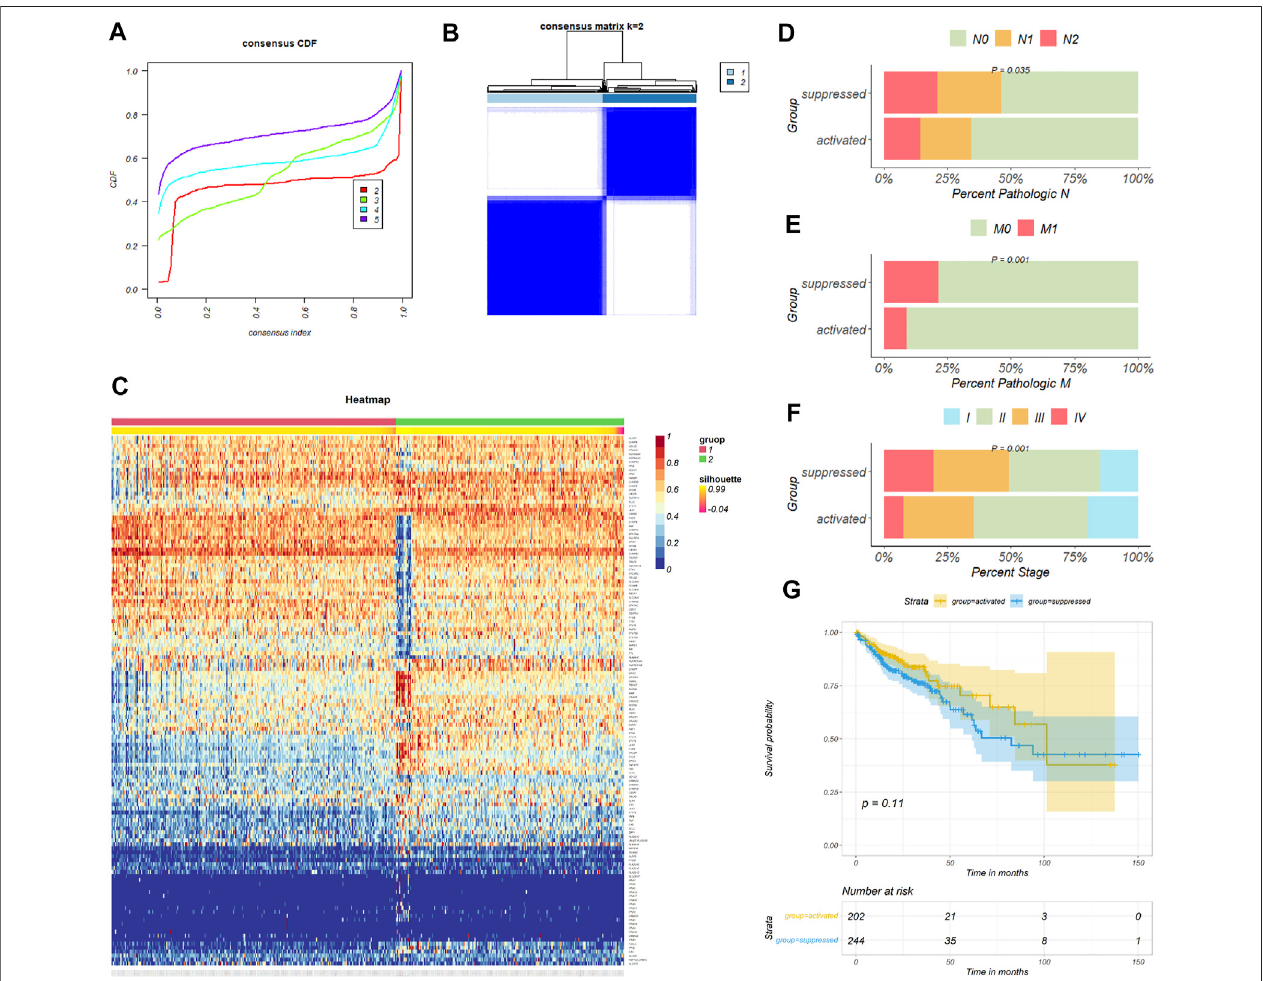
FIGURE2| Consensusclusteringfornecroptosisrelatedgenes(NRGs)incoloncancerpatients. (A) TherelativechangeinareaundertheCDFcurveofK=2 – 5. (B) The consensus matrix shows patients with two heterogenous necroptosis states in the TCGA-COAD cohort. (C) The heatmap shows expression levels of NRGs in the NRGs-activated and NRGs-suppressed group. (D – F) Difference of tumor pathological N, M, and clinical stage distribution between the two necroptosis subgroups respectively. (G) Kaplan-Meier curves for overall survival based on necroptosis subgroups (Log-rank test) in the TCGA-COAD cohort.